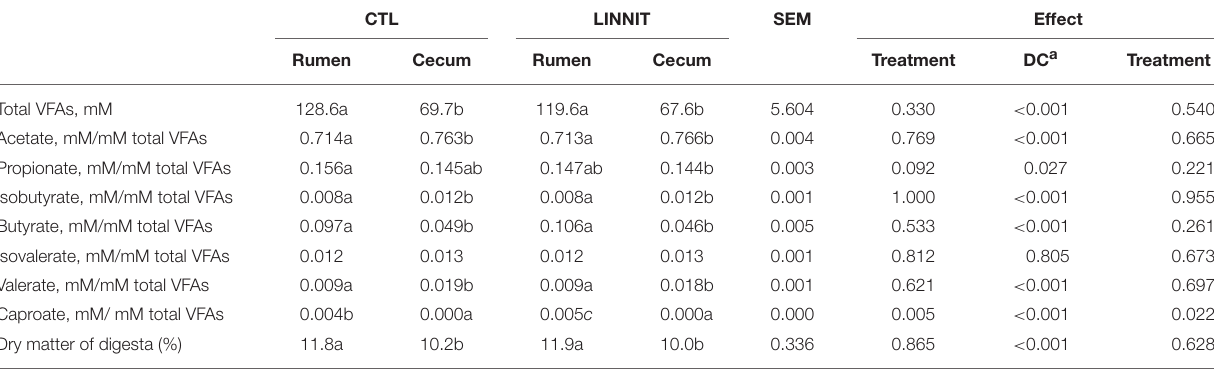
TABLE 2 | Volatile Fatty acids concentrations in rumen and cecum contents of bulls fed control (CTL) diet ( n = 8) or diet supplemented with a combination of linseed plus nitrate (LINNIT) ( n = 8). CTL LINNIT SEM Effect Rumen Cecum Rumen